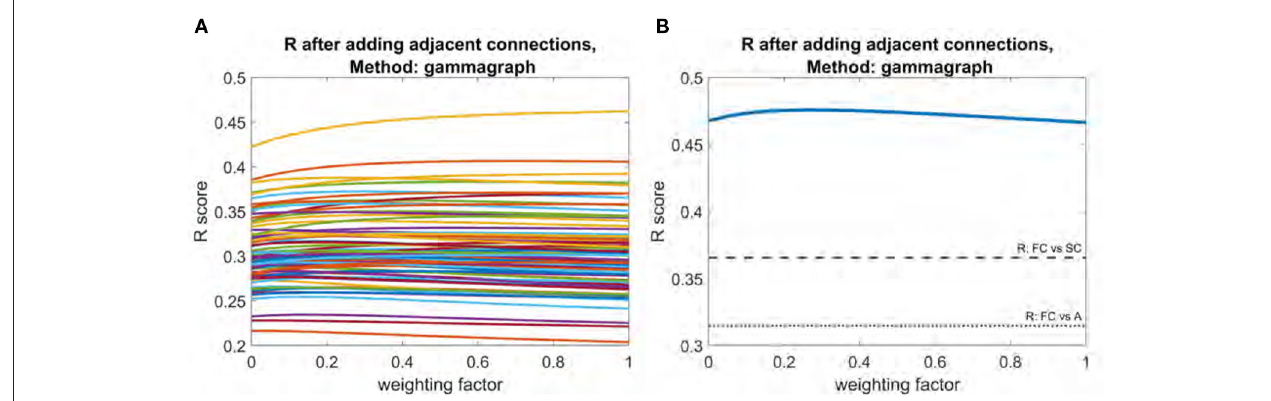
FIGURE 4 | Plot of R vs. weighting factor as adjacency matrix is added to SC. (A) R vs. weighting factor for all subjects, with each line representing an individual subject. (B) Model performance for the mean functional connectome. Dotted line indicates raw correlation between functional connectome and interhemispheric matrix. Dashed line indicates correlation between functional connectome and structural connectome.